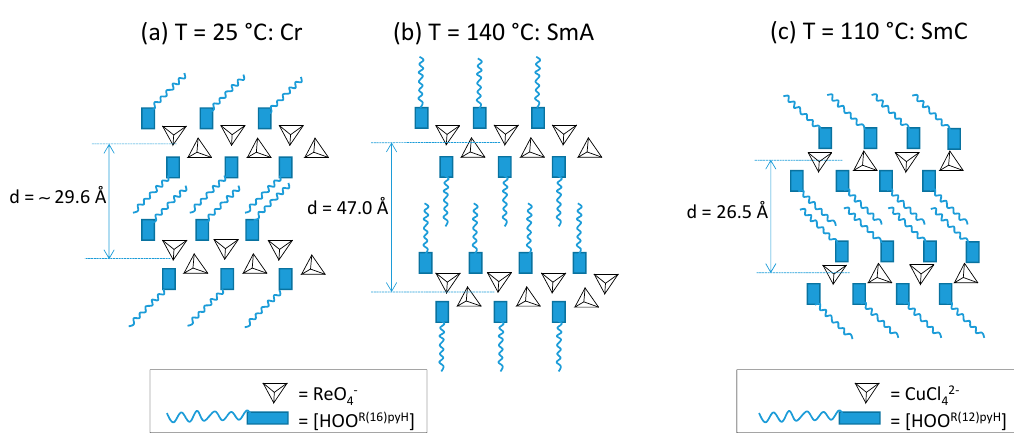
Figure 5. Schematic representation of the structural features: ( a ) [HOO R(16)pyH ][ReO 4 ] at the solid state based on the structure of ReO 4 -12 ; ( b ) proposal for [HOO R(16)pyH ][ReO 4 ] at the SmA mesophase; and ( c ) proposal for [HOO R(12)pyH ] 2 [CuCl 4 ] at the SmC mesophase.